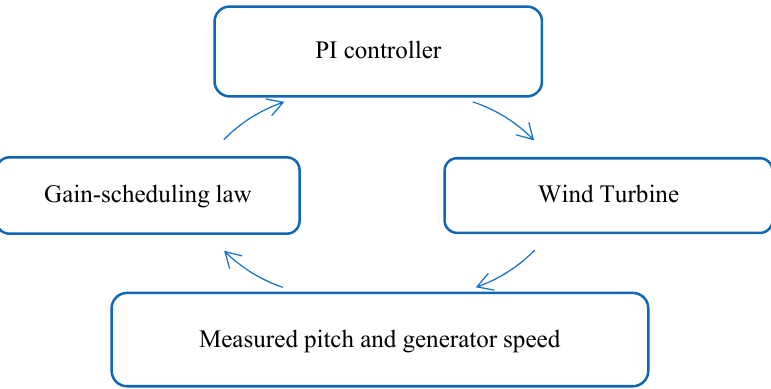
Figure 2. Simplified diagram for the reference PI controller structure .